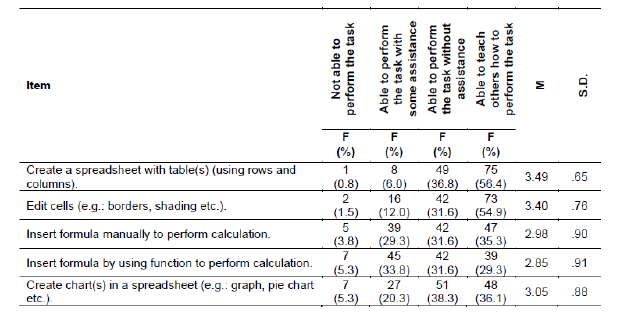
Table 6. Descriptive Statistics for Items on Word Processing Table 7. Descriptive Statistics for Items on